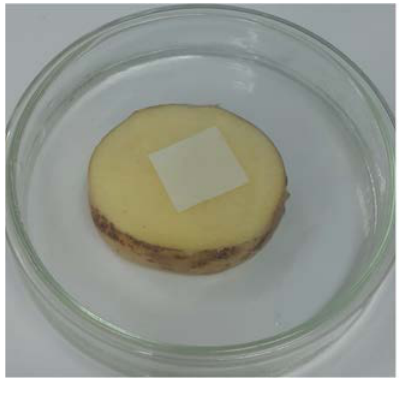
Figure 1. Slices of potato infected with SA